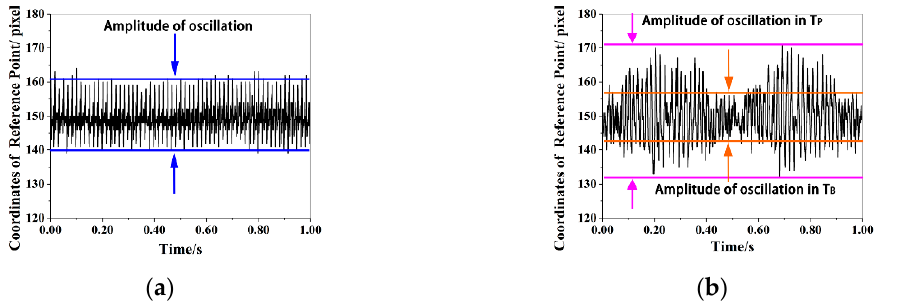
Figure 14. Height of reference point A as a function of time: ( a ) P-GMAW(No.12); ( b ) DP-GMAW(No.3).